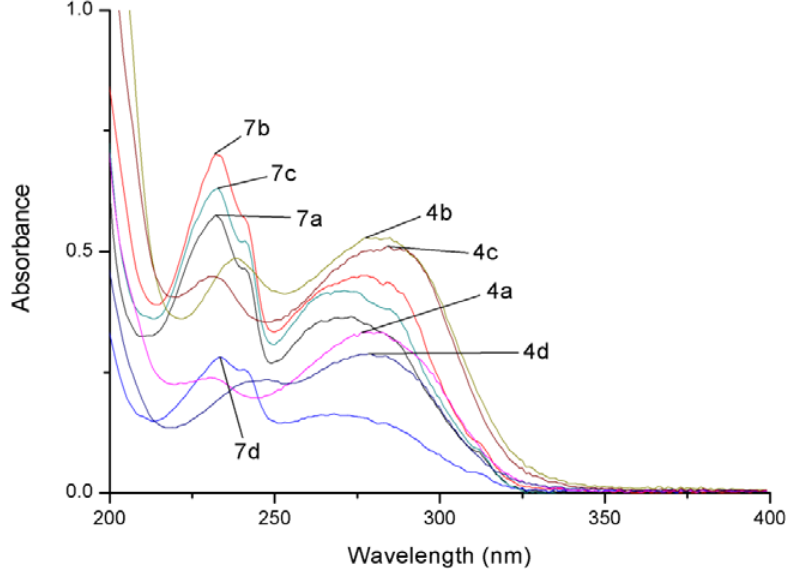
Figure 2. UV-VIS absorption spectra for compounds 4a – d and 7a – d .